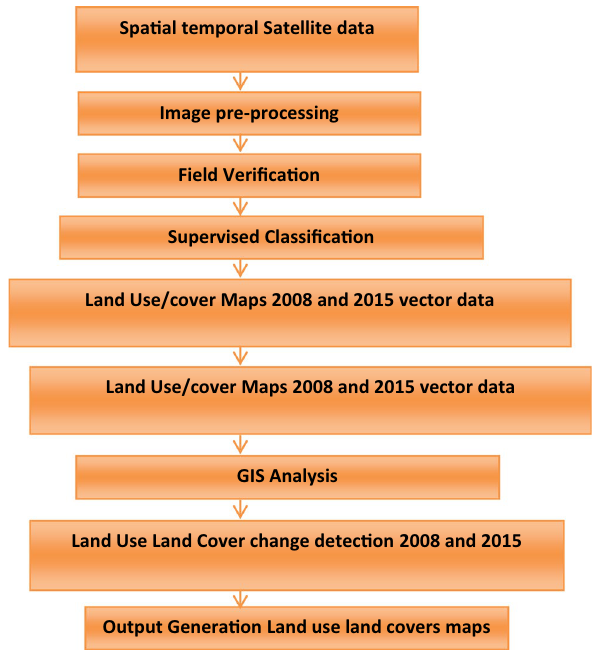
Fig. 2 Methodology used in Ruikhed watershed study